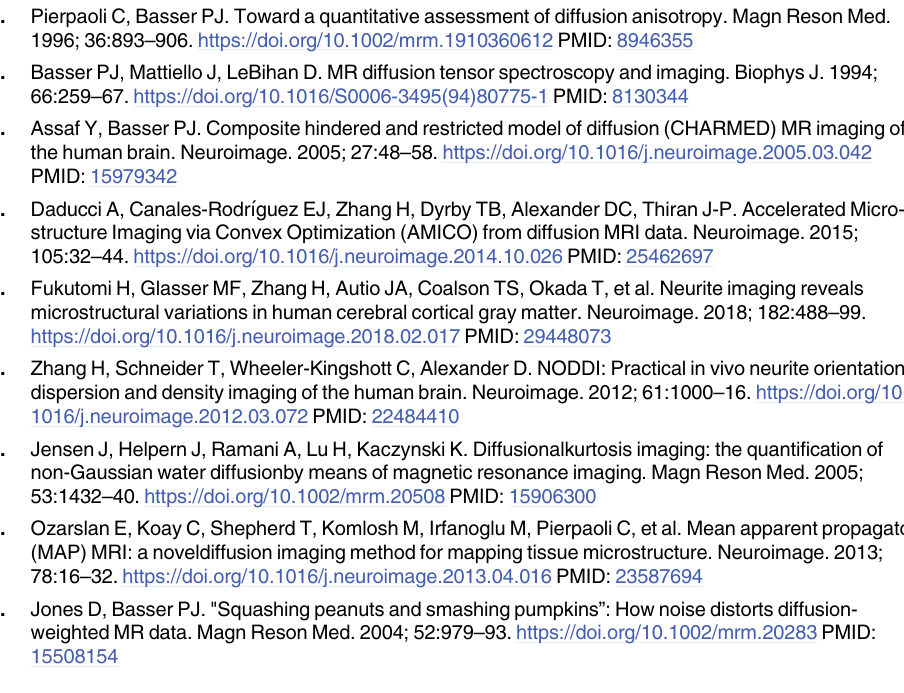
S2 Fig. Scatter plots of four diffusion metrics (FA, MD, OD, ICVF) derived from denoised data of subject 1 using the DWI data of subject 2 and 3 as training data, respectively.